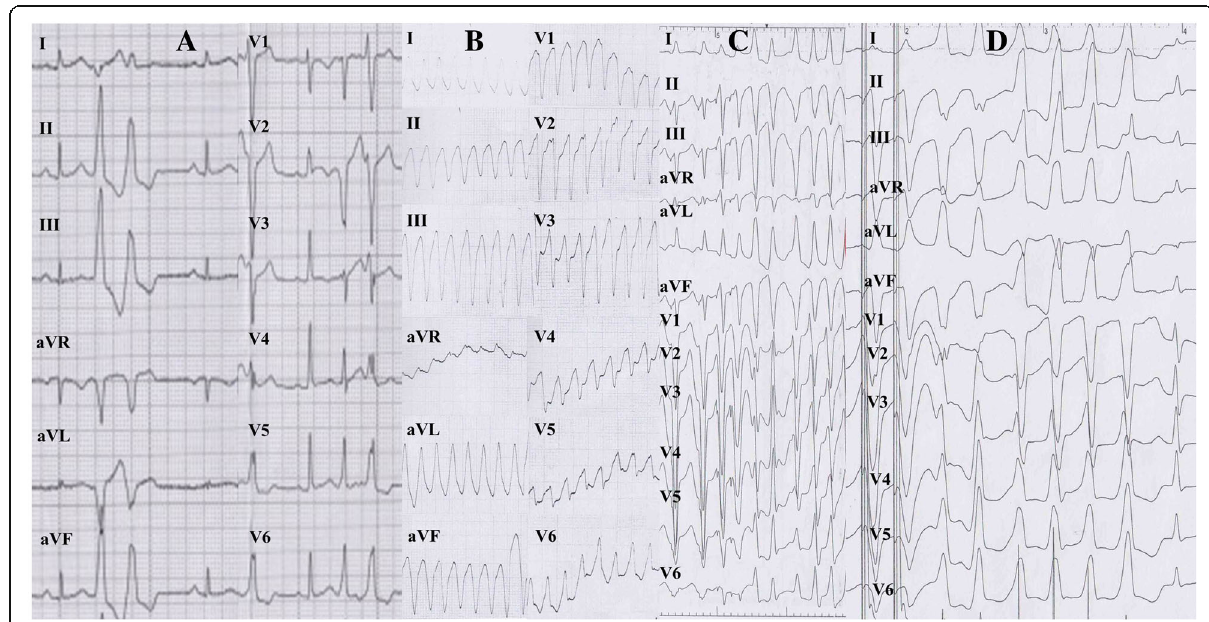
Fig. 2 ECGs characteristics of III:1 patient. a Inversion of T wave (V 1 -V 3 leads) in sinus rhythm; Pairs of ventricular premature beat origin from right ventricular tract; cardiac counterclockwise transposition. b Clinical episode of persistent and malignant ventricular tachycardia origin from the inflow-free wall of right ventricle. c – d Ventricular programed stimulation induced short episode of ventricular tachycardia origin from the inflow-free wall ( c ) and outflow tract of right ventricle ( d ), during first ablation in the other hospital